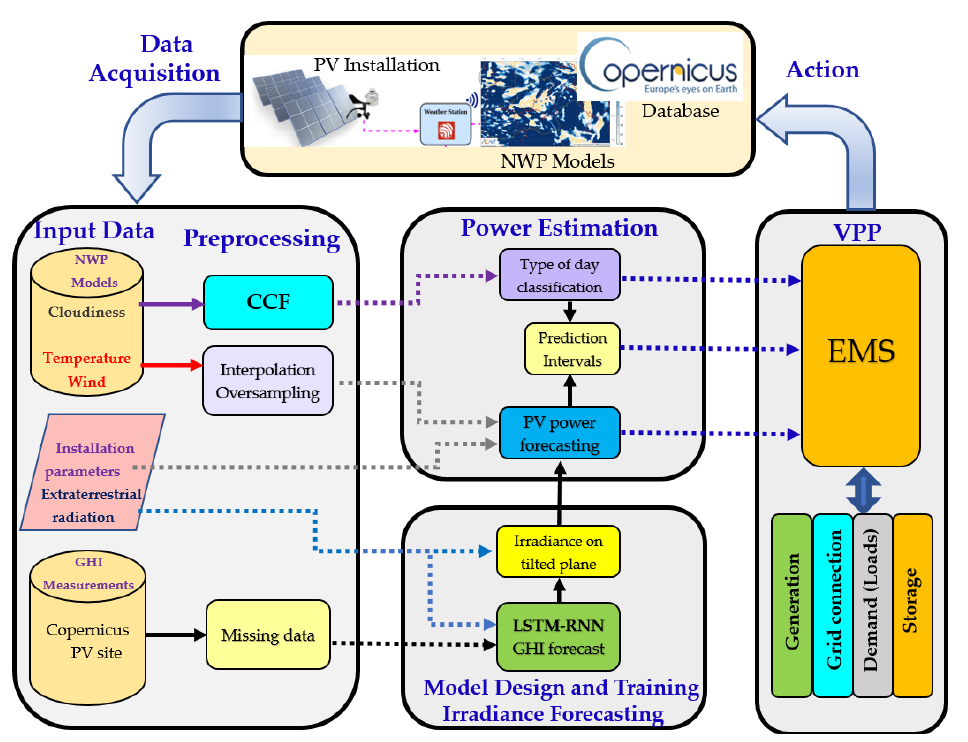
Figure 1. Forecasting